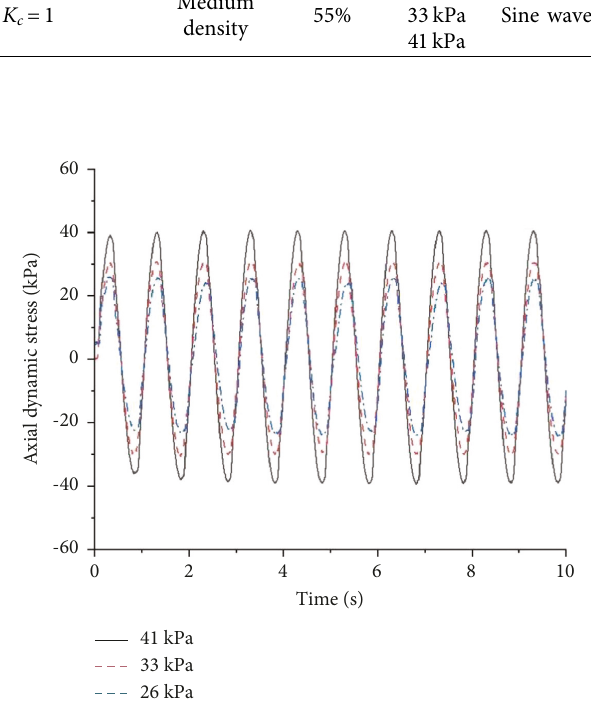
Figure 2: Time history comparison curve of axial dynamic stress of standard sand.